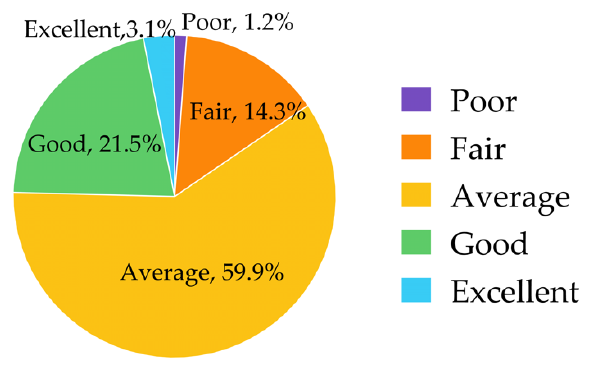
Figure 1. Knowledge of pharmacogenomic testing.